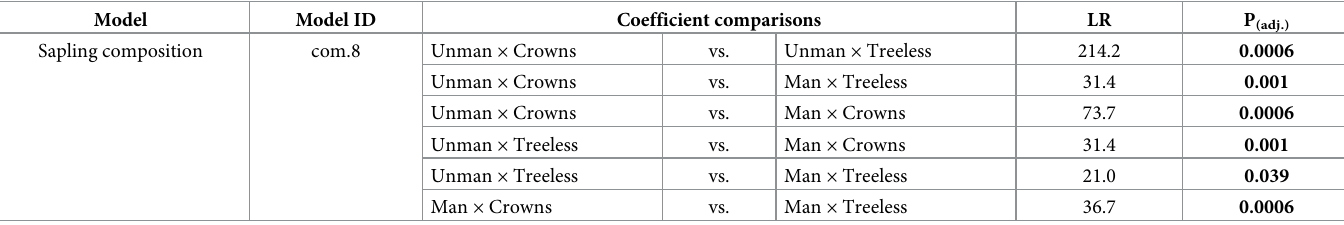
Table 3. Pairwise comparisons of species composition under different land management and araucaria crown influence in an upper-montane Araucaria forest, southern Brazil. Model Model ID LR P (adj.) Sapling